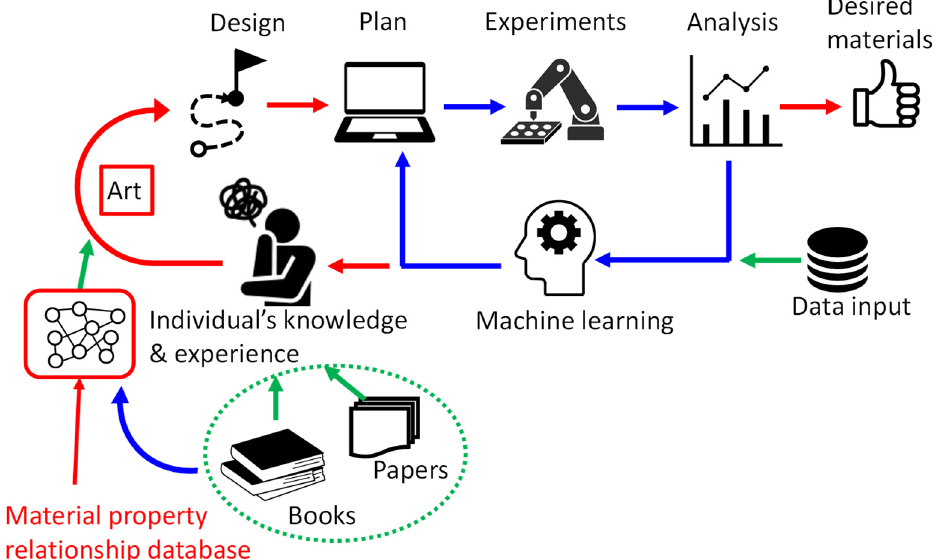
Figure 1. Schematic representation of research process consisting of automated loop with computer aid ( blue ) and human involvement in the process ( red ). Green arrows indicate information inputs.